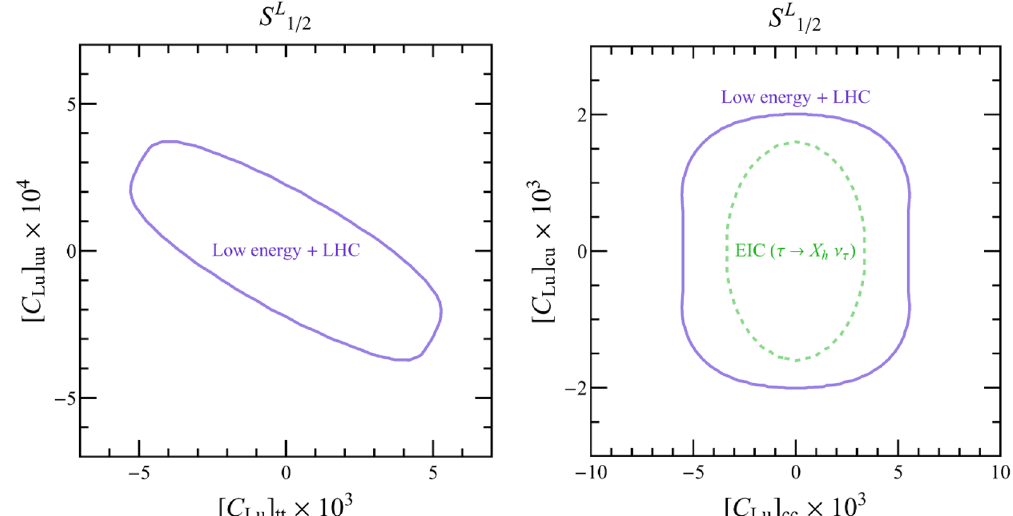
Figure 24 . The region of ∆ χ 2 < 2 . 71 in [ C Lu ] tt − [ C Lu ] uu (left) and [ C Lu ] cc − [ C Lu ] cu (right) planes. While the purple contour represents existing limits from low-energy experiments and the LHC, the dashed green line corresponds to the EIC expected sensitivity in hadronic τ decays under the assumption of (cid:15) = 1 with n = 0 . The projection of these regions onto each axis corresponds n b b to the 90% C.L. allowed region for that